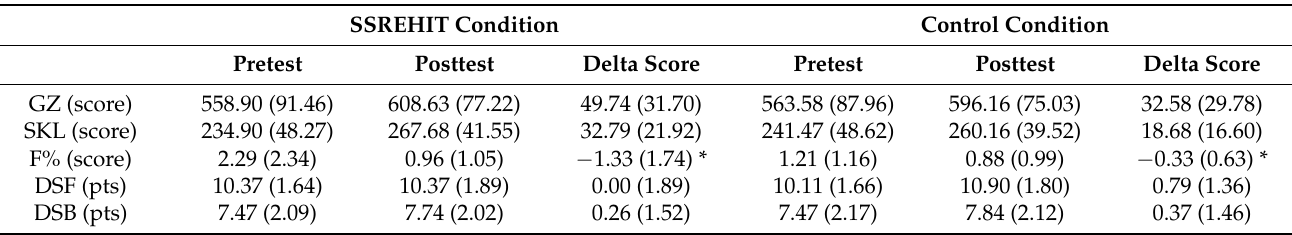
Table 2. Means (standard deviation) of the measures of cognitive performance. SSREHIT